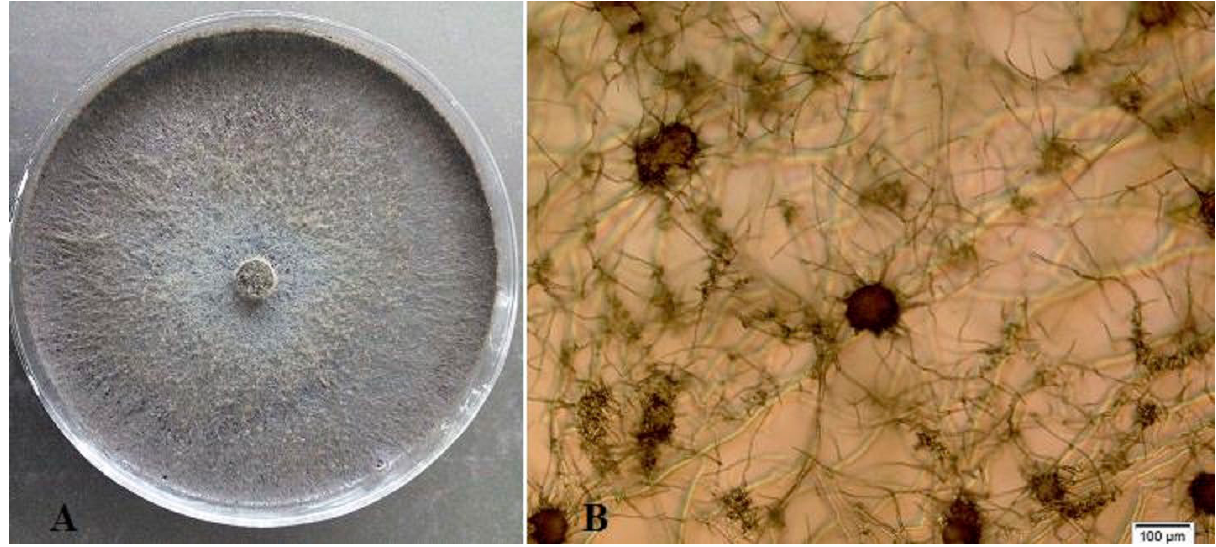
Figure 2. A. Colony morphology of Macrophomina phaseolina on PDA. B. Sclerotia on